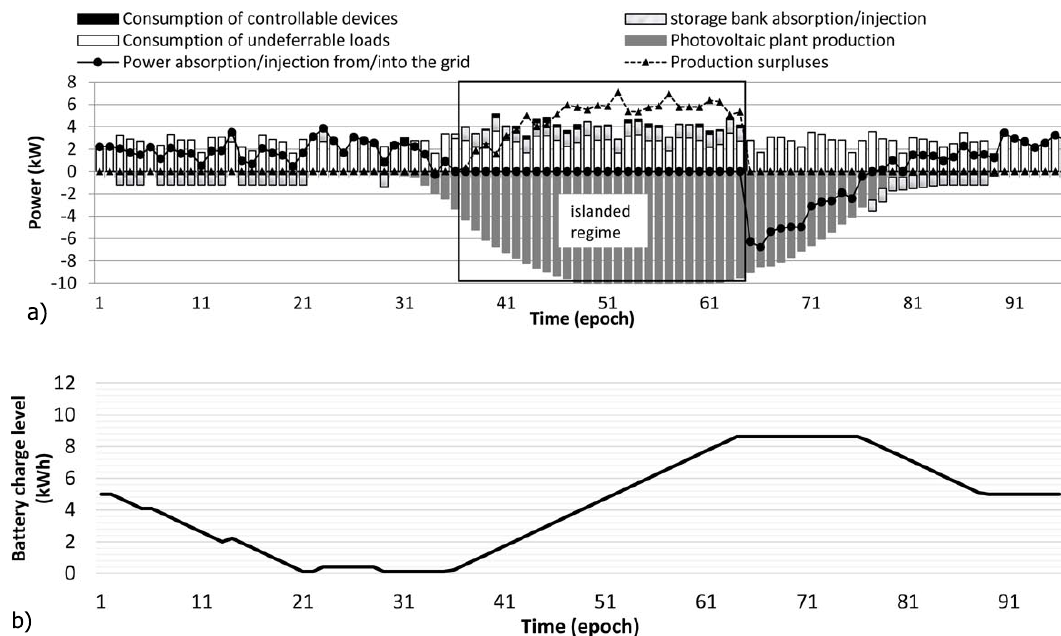
Figure 6. EMS schedule of daily energy exchanges with the electricity grid and storage bank charge/discharge periods ( a ) and storage bank charge level ( b ) during a sunny weekend day, when maximizing the period of islanded operational mode. values indicate energy purchases (sells), energy consumption (production) and battery charges (discharges).